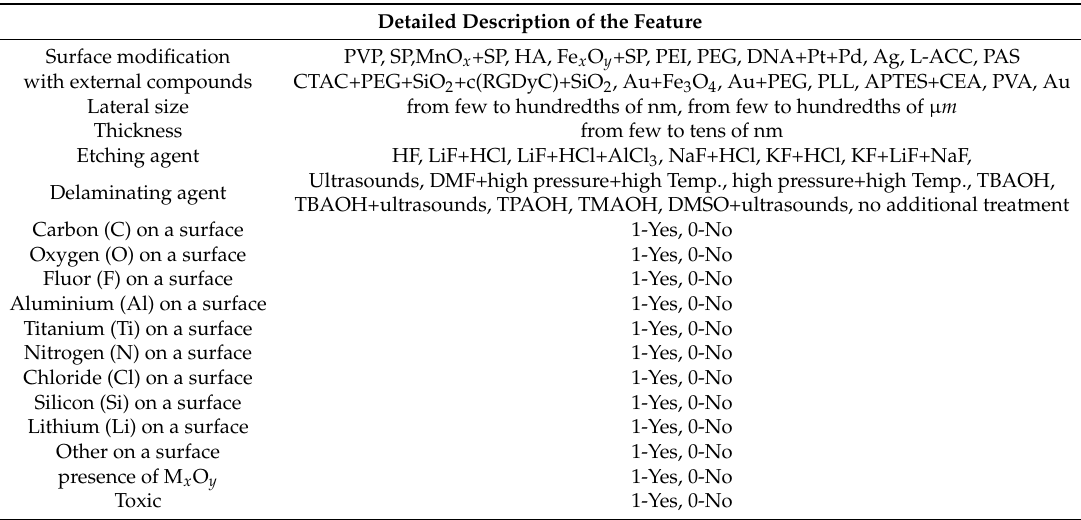
Table A2. Detailed description of the elemental features used in ML scheme and applied for the dataset I and dataset III.